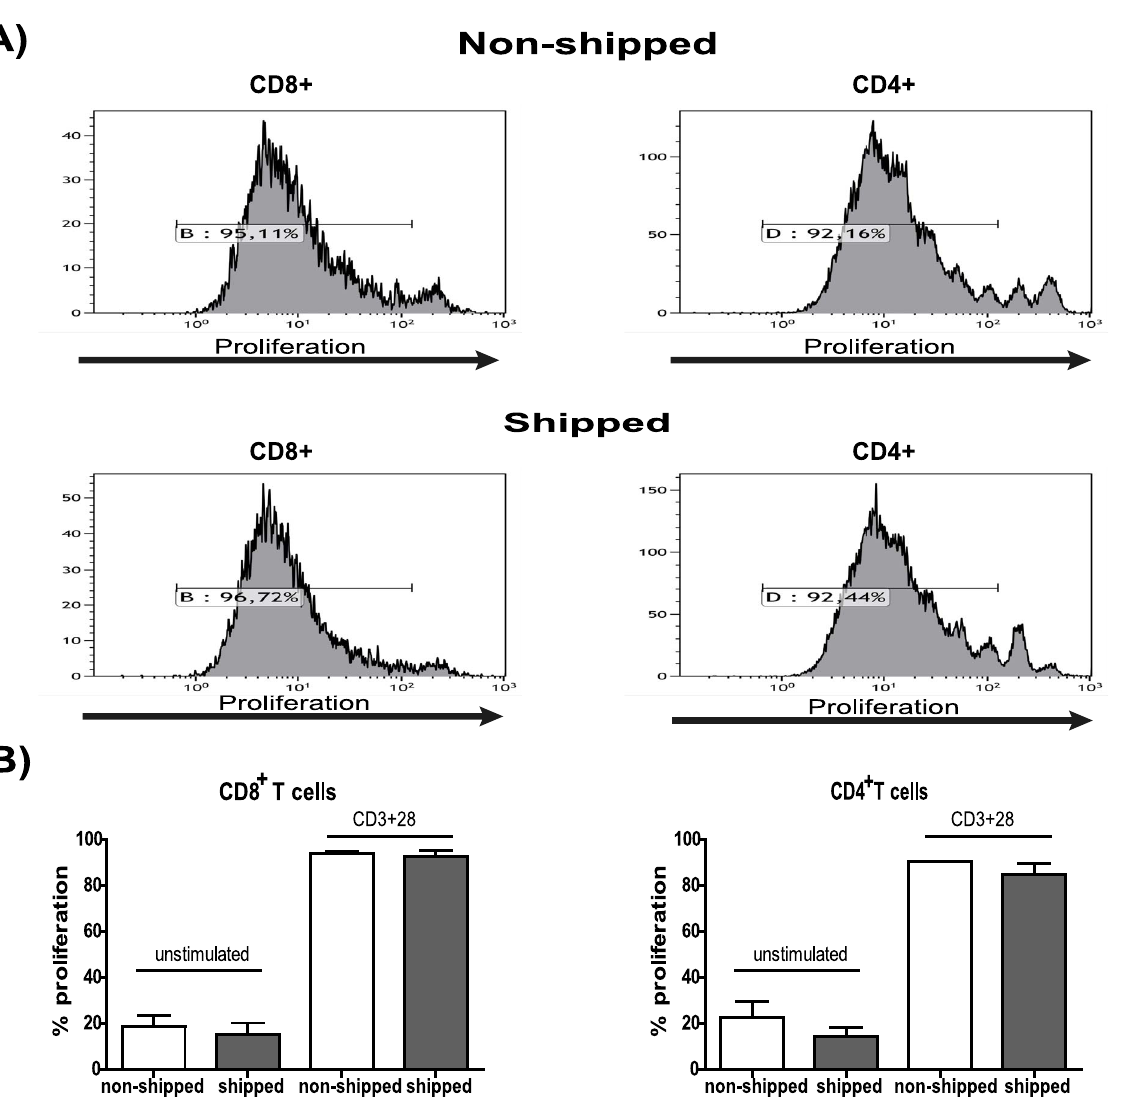
Fig. 3. The effects of overnight shipping on T cell proliferation. PBMC from non-shipped vs. shipped samples were thawed, loaded with eFluor670 cell proliferation dye and stimulated with plate bound anti-CD3 (OKT3) and soluble anti-CD28 antibodies for 6 days (as described in the methods). Cells were harvested and proliferation was analyzed by flow cytometry. A) A representative graph is shown for CD8 + and CD4 + T cell proliferation. B) Bar graphs summarize the percentage of proliferating CD8 + (left) and CD4 + (right) T cells of all donors (n 5 9).